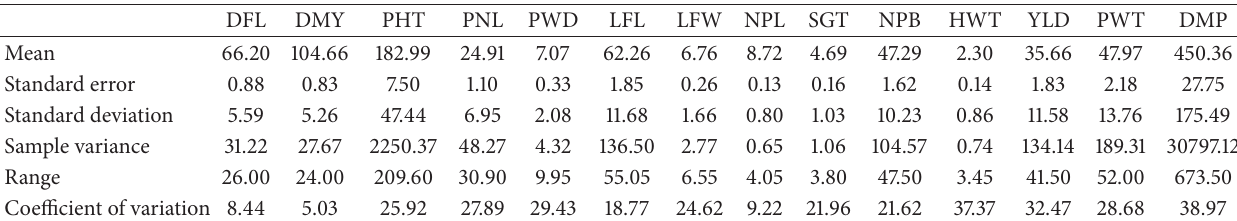
Table 2: Descriptive statistics of quantitative traits.